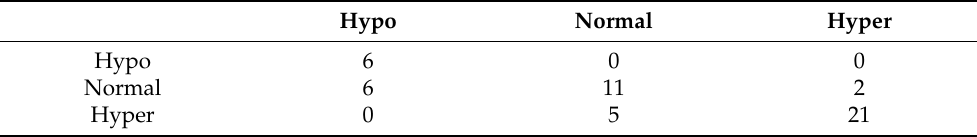
Table 6. Confusion matrix of Lumbar lordosis assessment through region area. Hypolordosis has no failure cases, while normal lordosis has eight, and hyperlordosis has five failure cases. Six cases of normal lordosis lie in hypo, while two cases lie in hyperlordosis. Five failure cases of hyperlordosis lie in normal lordosis.